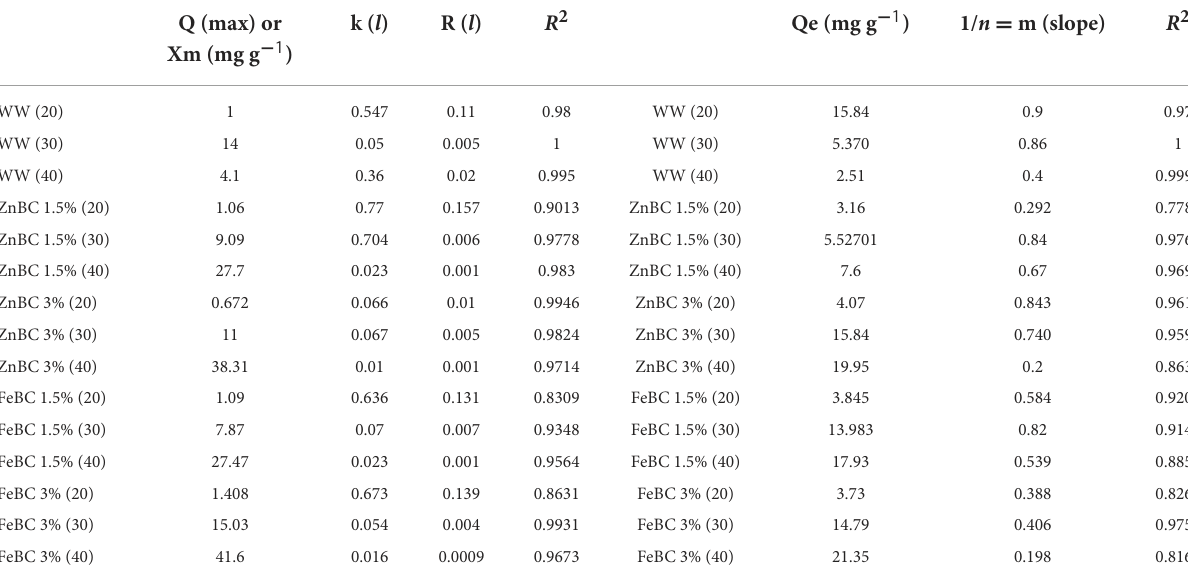
TABLE 4 FeBC and ZnBC metal adsorption capacity (20, 30, and 40 days) determined by Langmuir and Freundlich isotherms. Langmuir adsorption